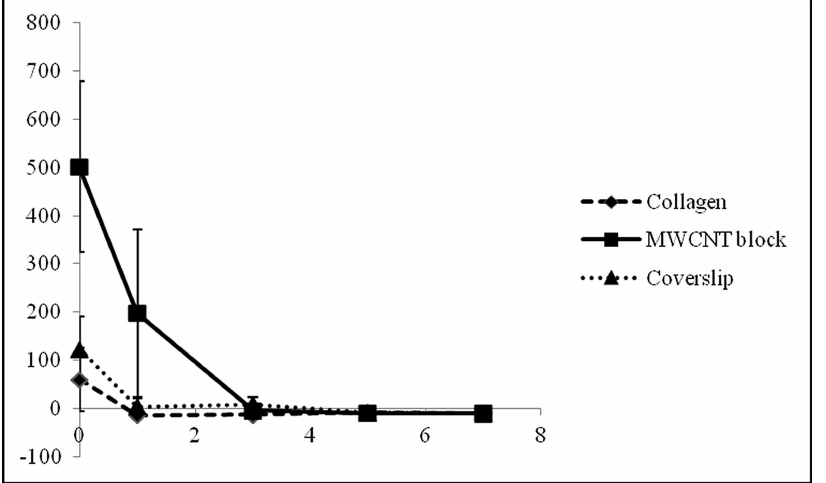
Fig 5. In vitro protein releasing assay. Graph shows the protein concentration of the supernatants in which MWCNT blocks, PET-reinforced collagensheets and coverslipswere immersed. Valuesare mean ± S.D.; n =